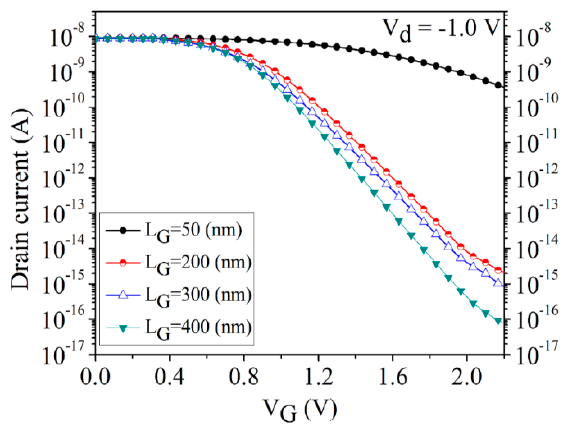
Figure 2. The transfer characteristics of the devices with lateral gate length of 50, 200, 300, and 400 nm when the gate voltage varied from 0 V to +2.0 V and V D = − 1.0 V.